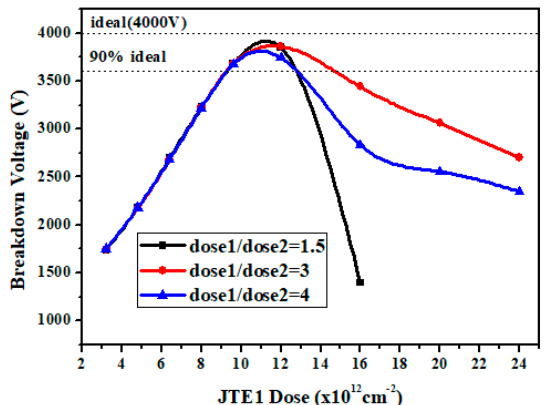
Figure 3. Simulated breakdown voltage (BV) versus ratio of the doses with different doses for the DZ-JTE optimization.